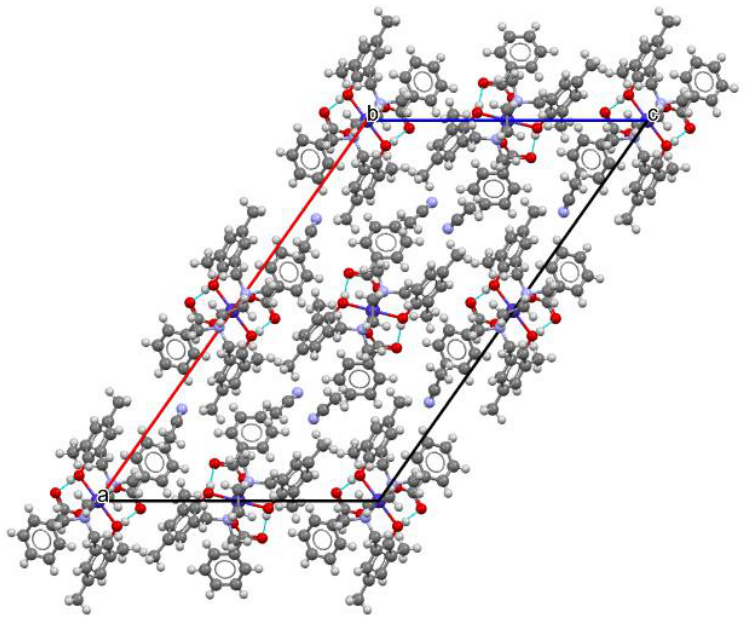
Figure 3. Crystal structure packing viewed down the b axis with hydrogen-bonding contacts shown as blue dashed lines.